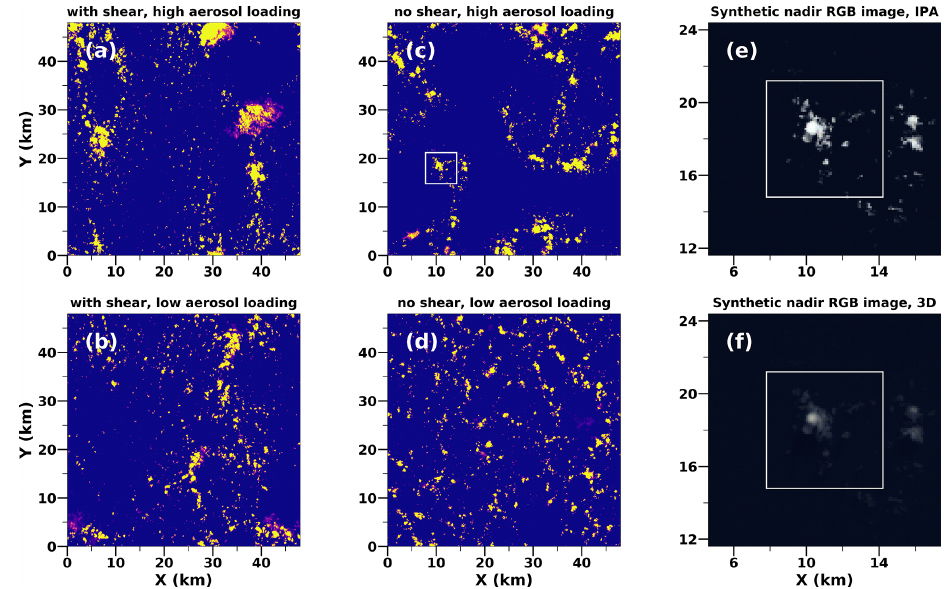
Figure 3. (a)–(d) LES COT fields from the 7SEAS campaign in the Sulu Sea with and without wind shear and with low and high aerosol load- ing (the maximum COT is capped at 4 to emphasize low-COT regions). Panels (e) and (f) show synthetic radiance calculations (red = 600nm, green = 500nm, blue = 400nm) with IPA and 3D, shown for the 6.4km × 6.4km sub-domain (white box) in (c) . All observations are of a hypothetical satellite imager at an altitude of 705km with a solar zenith angle of 30 ◦ (with nadir viewing angle) and a solar azimuth angle of 0 ◦